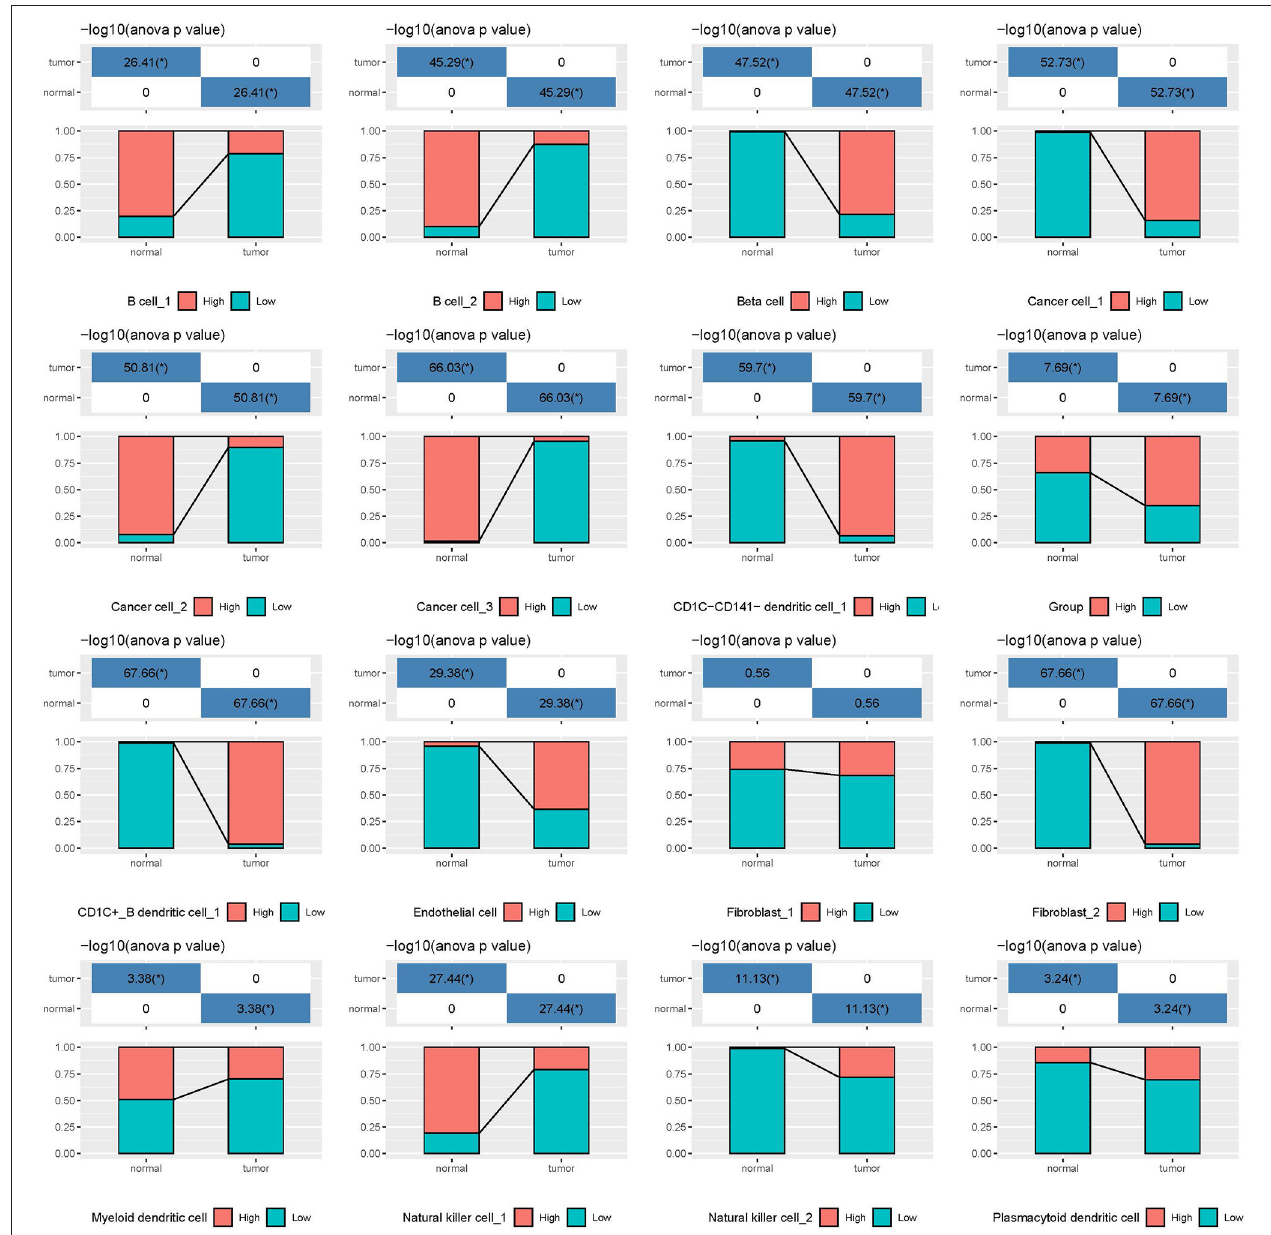
FIGURE 7 | The independent proportion of 16 subgroups in normal and tumor samples. High and low indicates the enrichment of cell types. * p < 0.05.